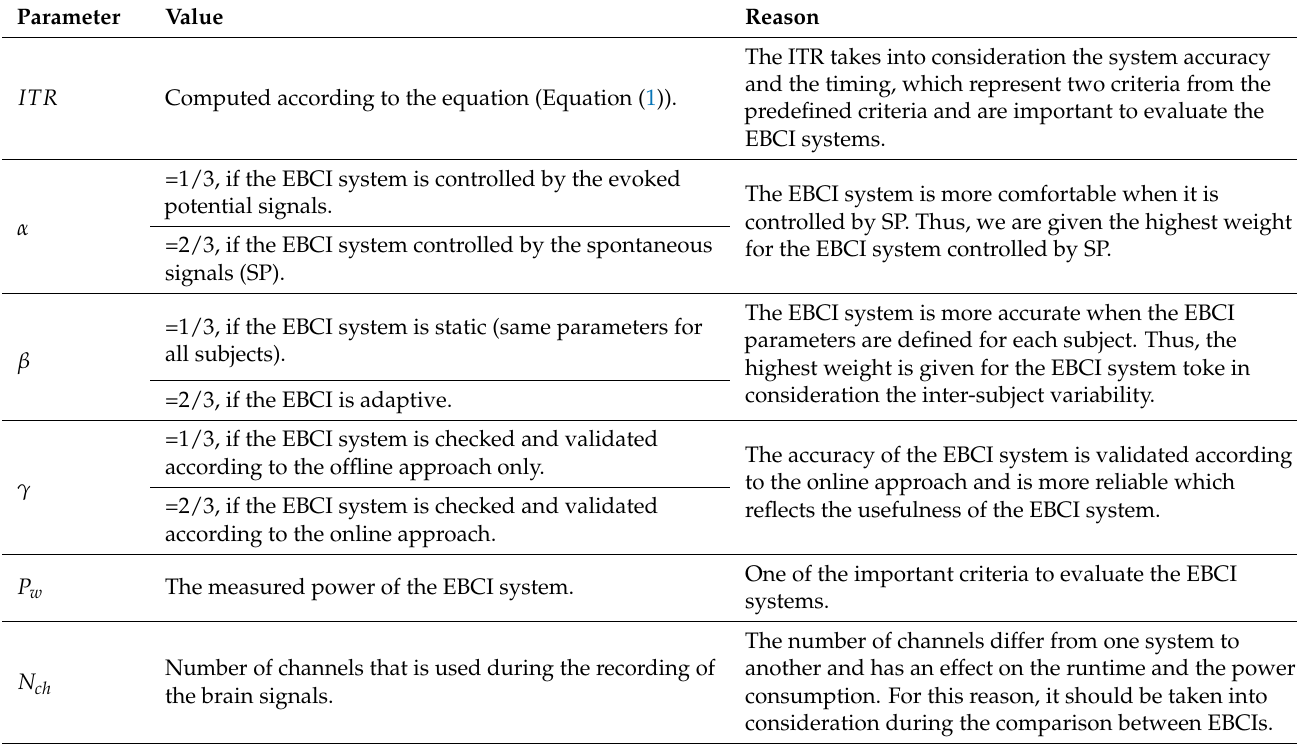
Table 4. Parameters of the evaluation criteria E c